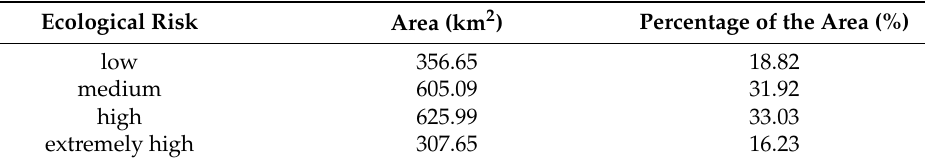
Table 5. Areas of different landscape ecological risk levels.